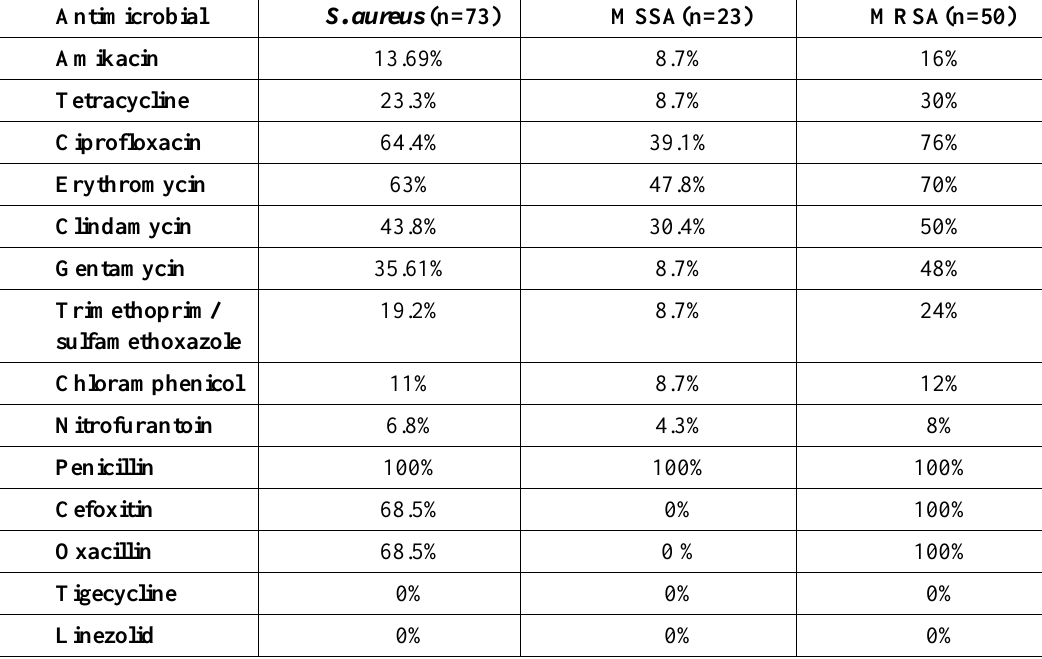
Table 3. Antimicrobial susceptibility pattern of Staphylococcus aureus isolates: (%) of resistant isolates by disc diffusion